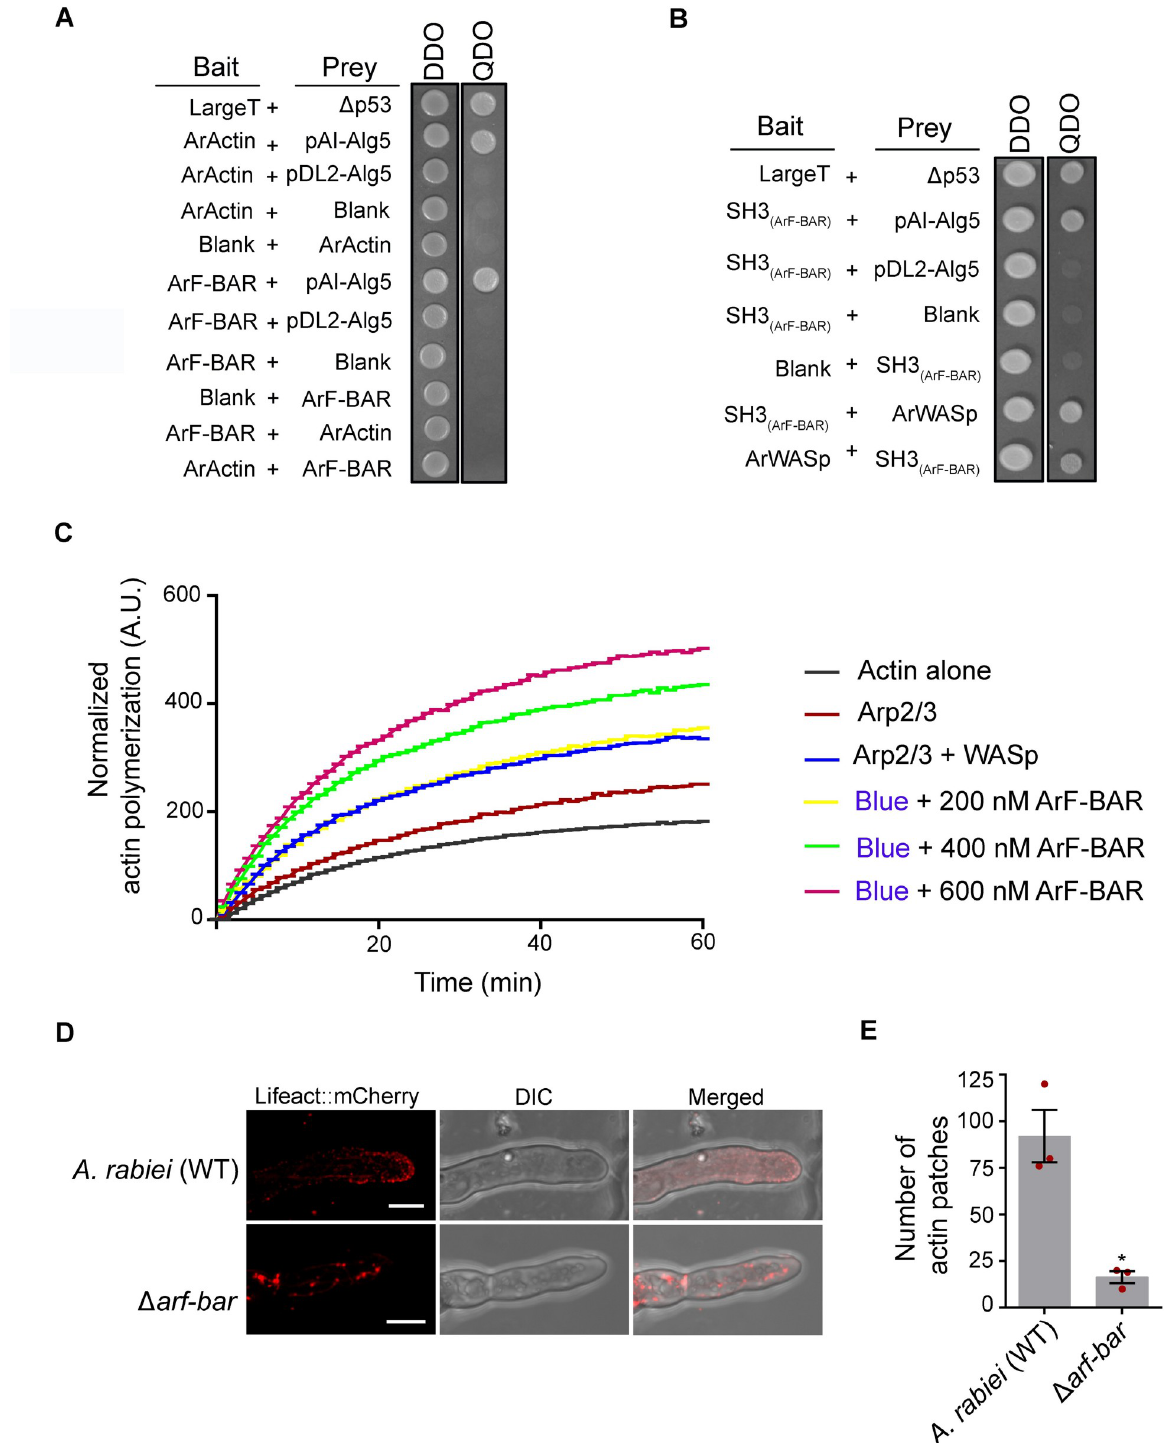
Fig 7. ArF-BAR modulates the actin cytoskeleton. (A) Split-ubiquitin based yeast two-hybrid assay to check protein-protein interaction in yeast cytoplasm. The lack of growth for yeast colonies on interaction selective QDO (SD/-L-W-A-H) media as compared to vector selective DDO (SD/- L-W) suggest no interaction between ArF-BAR and ArActin. The LargeT and Δ p53 are interaction positive controls while pAI-Alg5 and pDL2-Alg5 are the controls to check bait expression and autoactivation, respectively. (B) ArF-BAR exhibits positive interaction with ArWASp through its SH3 domains [SH3 (ArF-BAR) ; 508–760 amino acids]. The representative images were photographed 48 h after spotting 10 μ l yeast